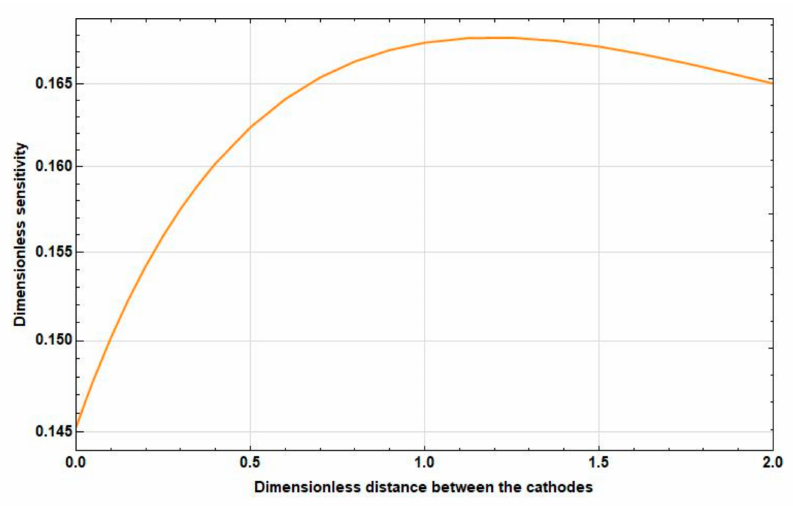
Figure 6. Dependence of the sensitivity on the intercathode distance at ˜ f = 0.025.